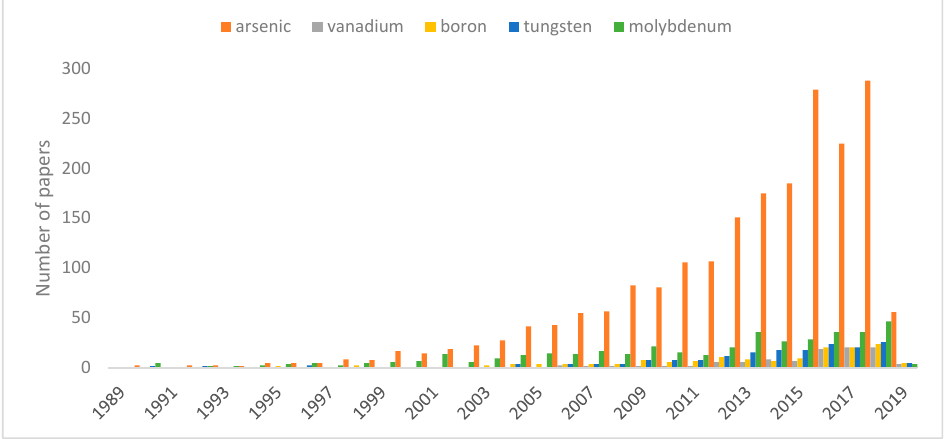
Figure 10. Bar chart of the number of articles per year about oxyanions adsorption for the 1989–28 January 2019. The statistical data was obtained by searching “adsorption metal oxide arsenite and arsenate/vanadate/borate/tungstate/molybdate” in the Scopus data base as title and keywords. The environment pH influences as well metal chemistry in solution (occurrence of various oxyforms) as the metal (hydr)oxide surface’s protonation/deprotonation [68]. Thus in most cases it is